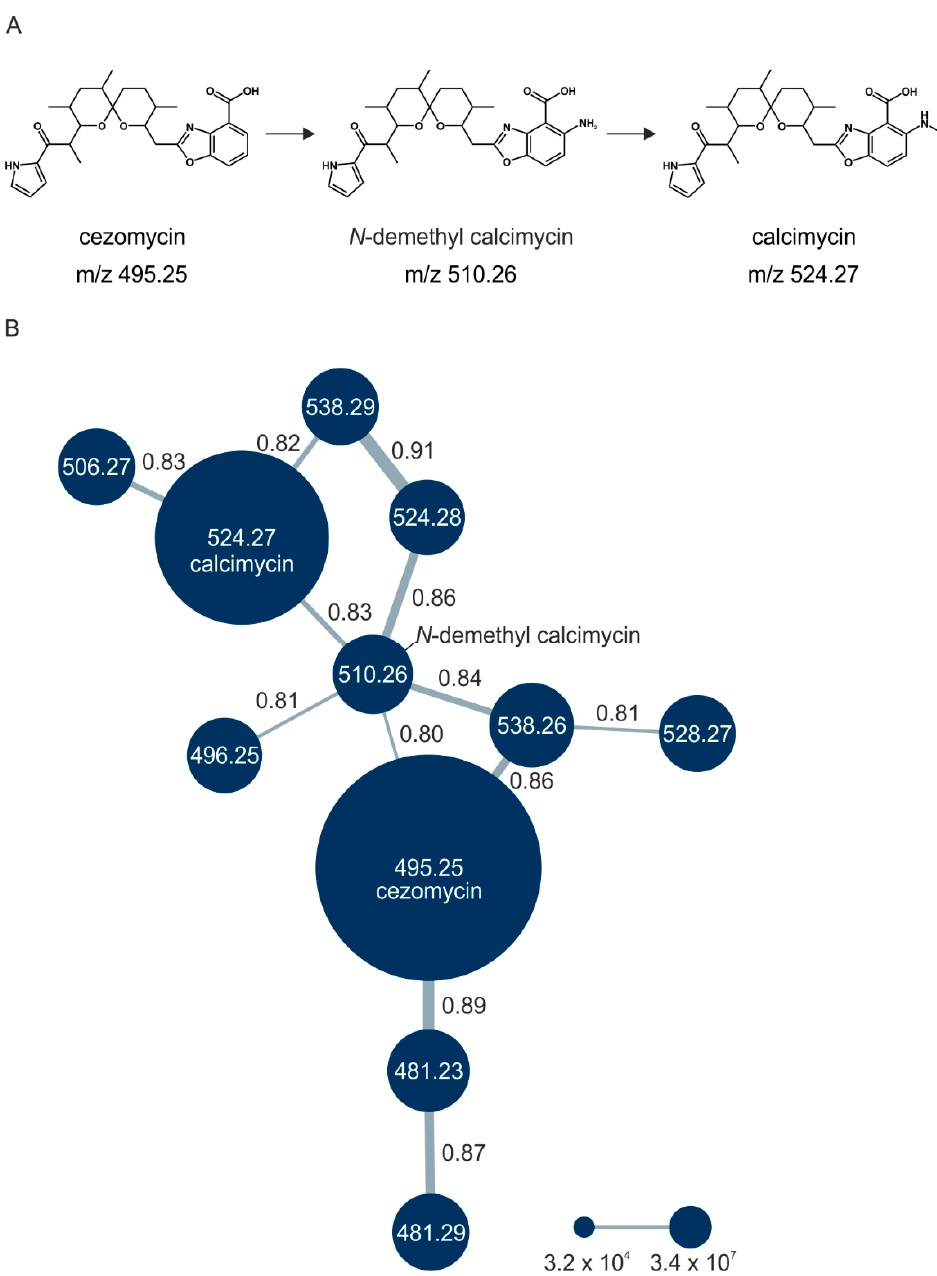
Figure 1. ( A ) Molecular structures of cezomycin, N -demethyl calcimycin and calcimycin are shown in successive steps of their biosynthesis in S. chartreusis . ( B ) Molecular network of calcimycin analogs. All calcimycin-like metabolites measured in the supernatants of 20 media, each supplemented with one of the proteinogenic amino acids, were clustered according to their cosine similarity calculated from their fragmentation patterns. Analogs with a similarity score of 0.7 or higher were clustered together by a connecting line. The line thickness indicates the degree of structural similarity of the analogs, with the score given above/beside the line. Each node in the cluster resembles one molecule, the measured mass [M+H] + is given with two decimals places here (Table 2 provides all four decimal places). Node size indicates the analogs’ abundance. Small nodes equal 3.2 × 10 4 , largest node equals 3.4 × 10 7 . Abundance was calculated based on area under the curve summed across all 20 growth conditions. Calcimycin: [M+H] + 524.27, cezomycin: [M+H] + 495.25, N -demethyl calcimycin: [M+H] + 510.26, others: structurally unknown. All experiments were performed in biological triplicates, except the cultivation with glutamine supplementation, which was done in duplicate.